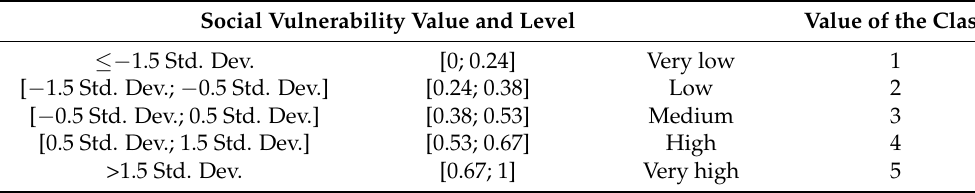
Table 3. Classification of social vulnerability calculated at the BGRI scale his is a table. Social Vulnerability Value and Level Value of the Class ≤− 1.5 Std. Dev.